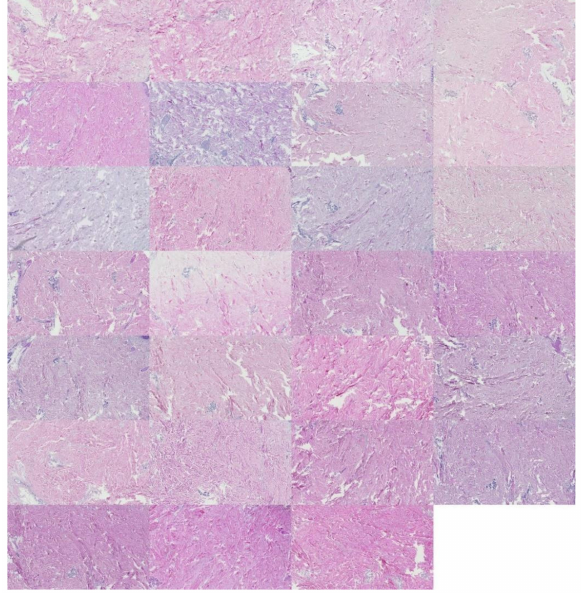
Figure A7. Skin examples visualized by descending silhouette score within the first found cluster (C1). Silhouette values descend in the left direction from the left-most example in the first row.